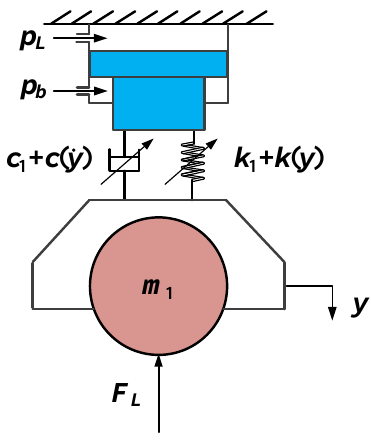
Figure 2. Vertical vibration model of load.